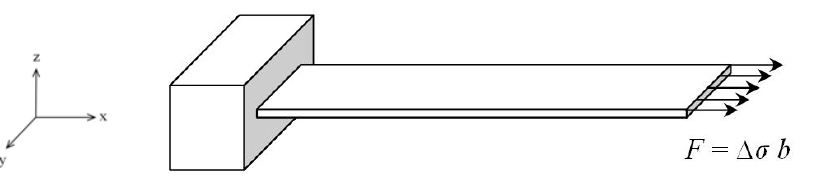
Figure 1. Modelling the surface stress induced deflection in a microcantilever by in-plane tensile force acting on the top